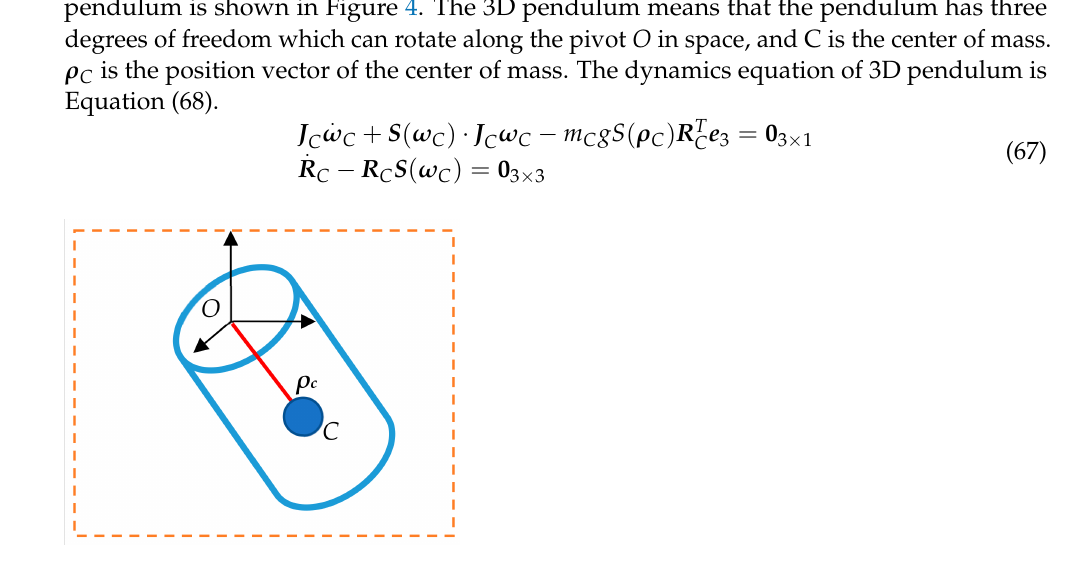
Figure 4. 3D rigid